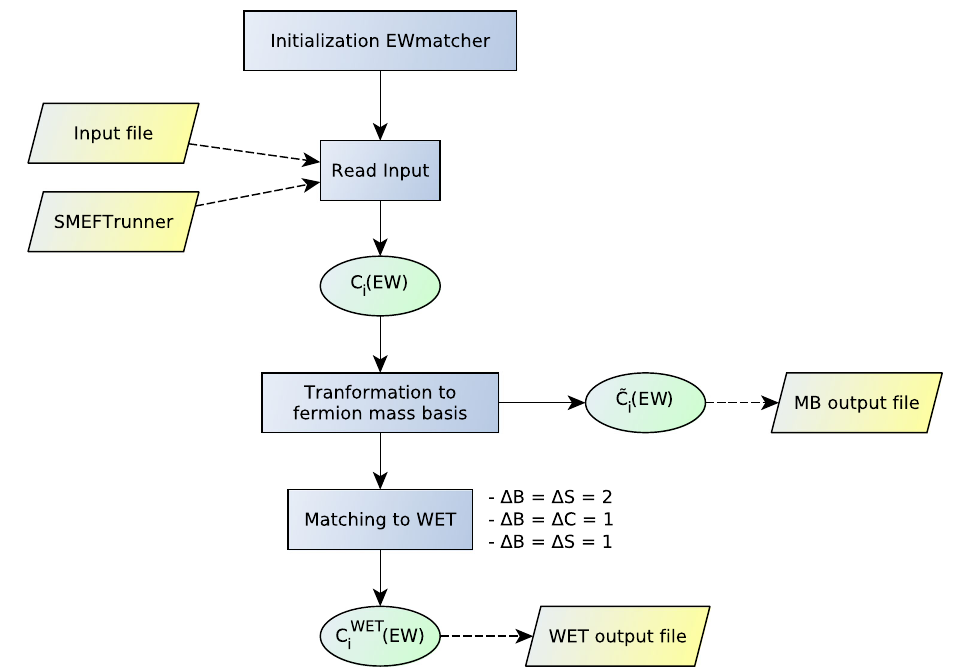
Fig. 4 EWmatcher module